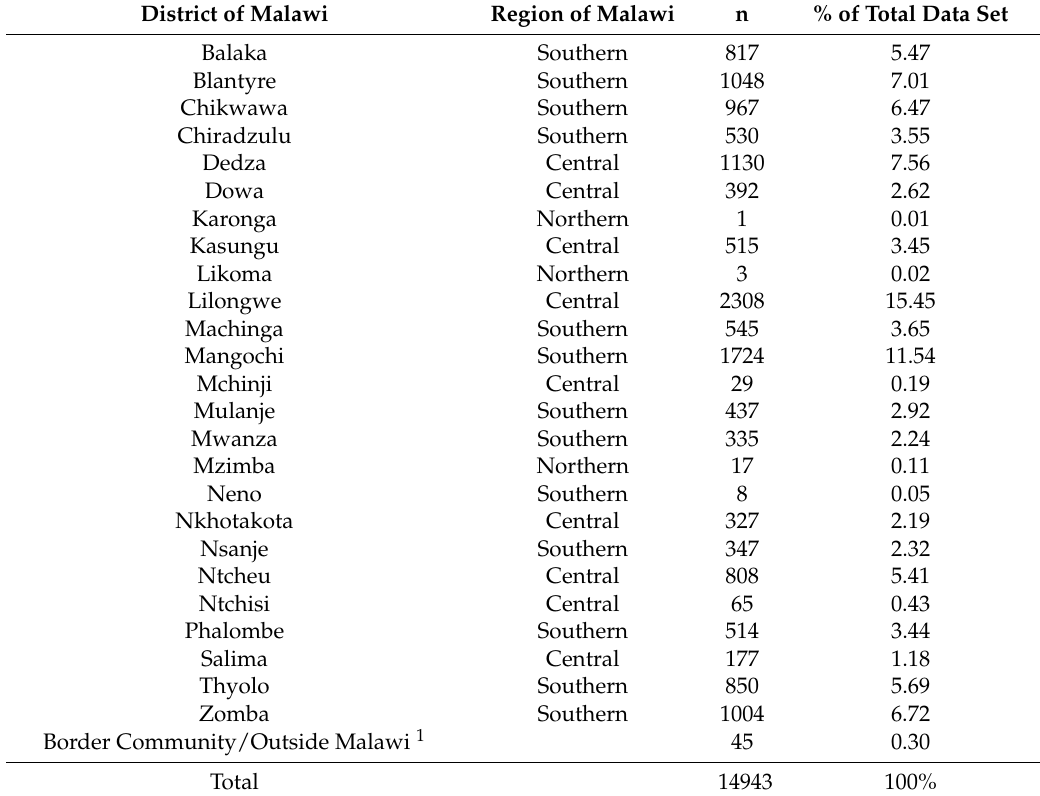
Table A1. Locations and distribution of Afridev hand pump boreholes installed between 2000–2016 mapped to date by the CJF using the MIS platform mWater (as of January